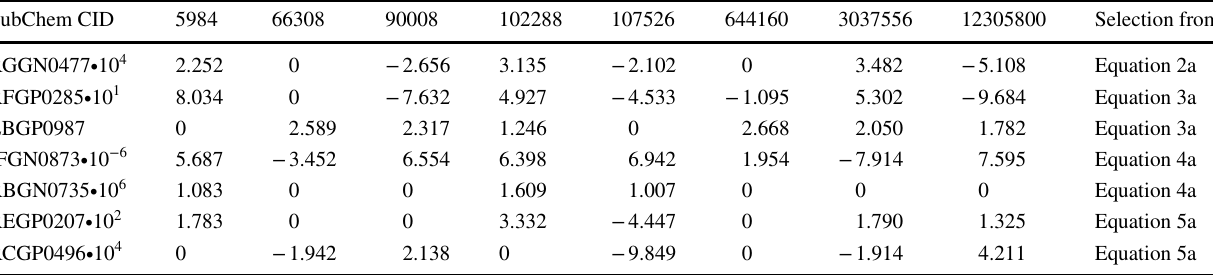
Table 5 Selected descriptors with highest explanatory power